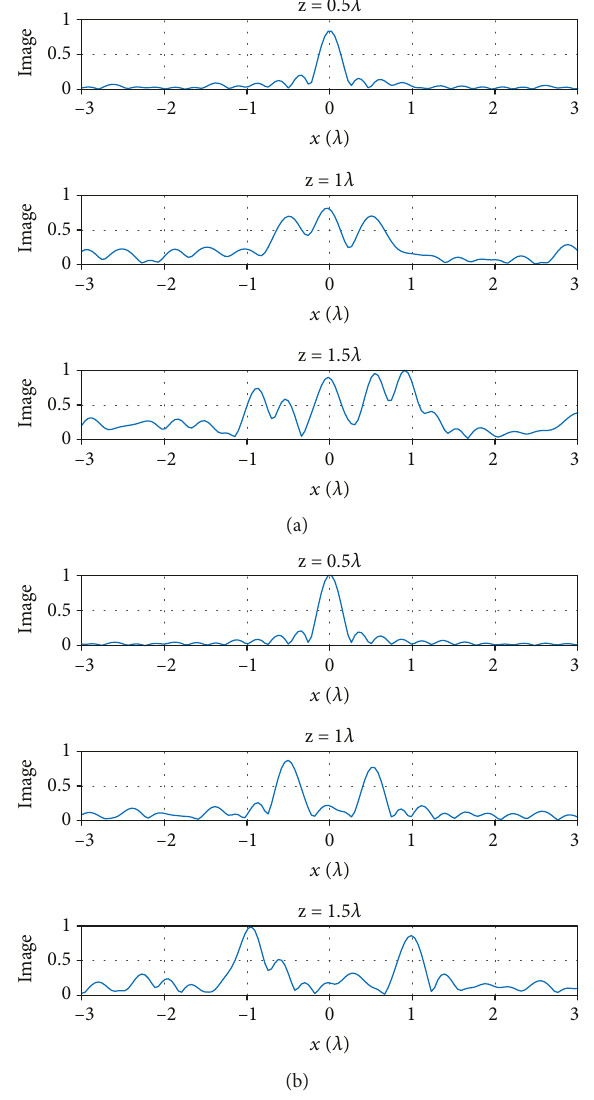
Figure 15: Reconstructed images when using one resonant dipole antenna and multiple frequency data: (a) using 8 frequencies with frequency range of 6.2GHz to 6.9GHz (100MHz sampling step) and (b) using 8 frequencies with frequency range of 5.8GHz to 7.2GHz (200MHz sampling step). For this example, the parameters are z =0.5 λ , z = λ , z =1.5 λ , d = λ , d =2 λ , and s = λ / 1 2 3 2 3 8. These results are with SNR=20 dB.